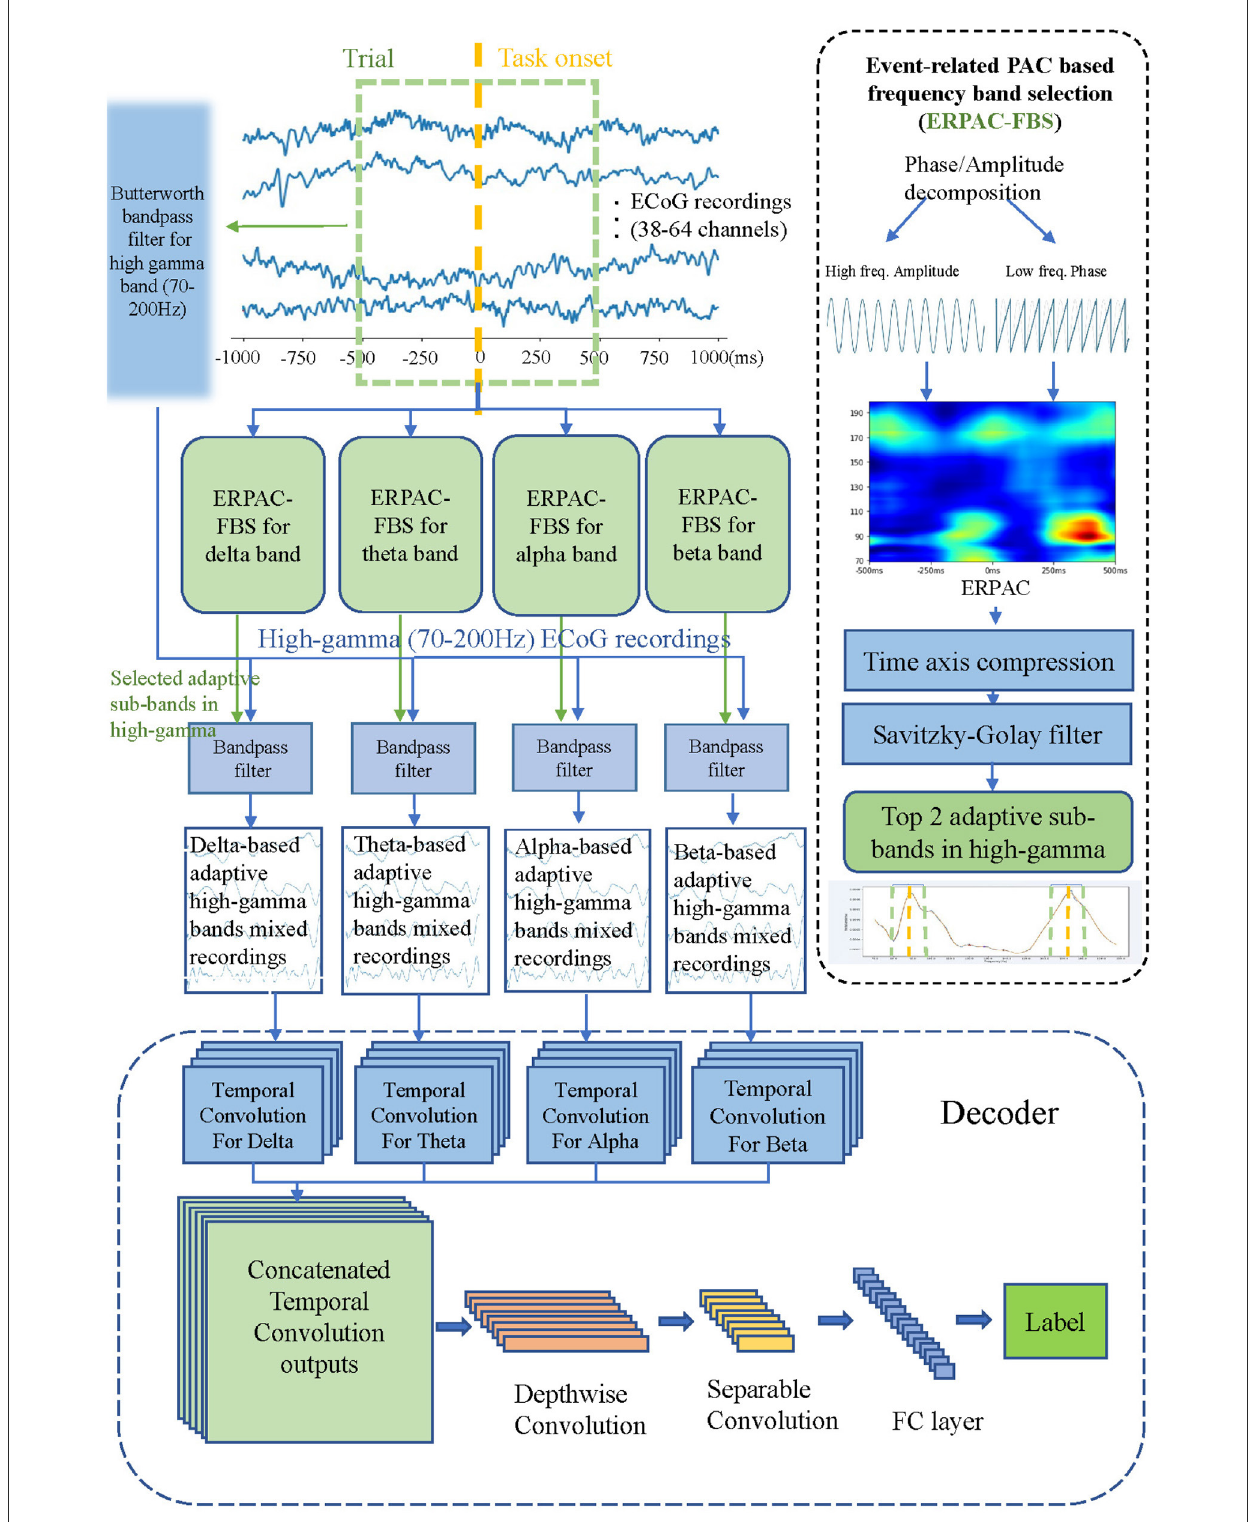
FIGURE1 Framework of the PACNet, including the flow chart of our kernel module: Event-related PAC based frequency band selection algorithm (ERPAC-FBS) and the proposed deep network structure. First, we use ERPAC-FBS to get two best sub-bands in the high-gamma range based on each low-frequency band, and then these two sub-bands are used to carry out band-pass filtering on the high-gamma signal, and the corresponding target signal is obtained. Finally, we put these mixed corresponding target signals into the proposed